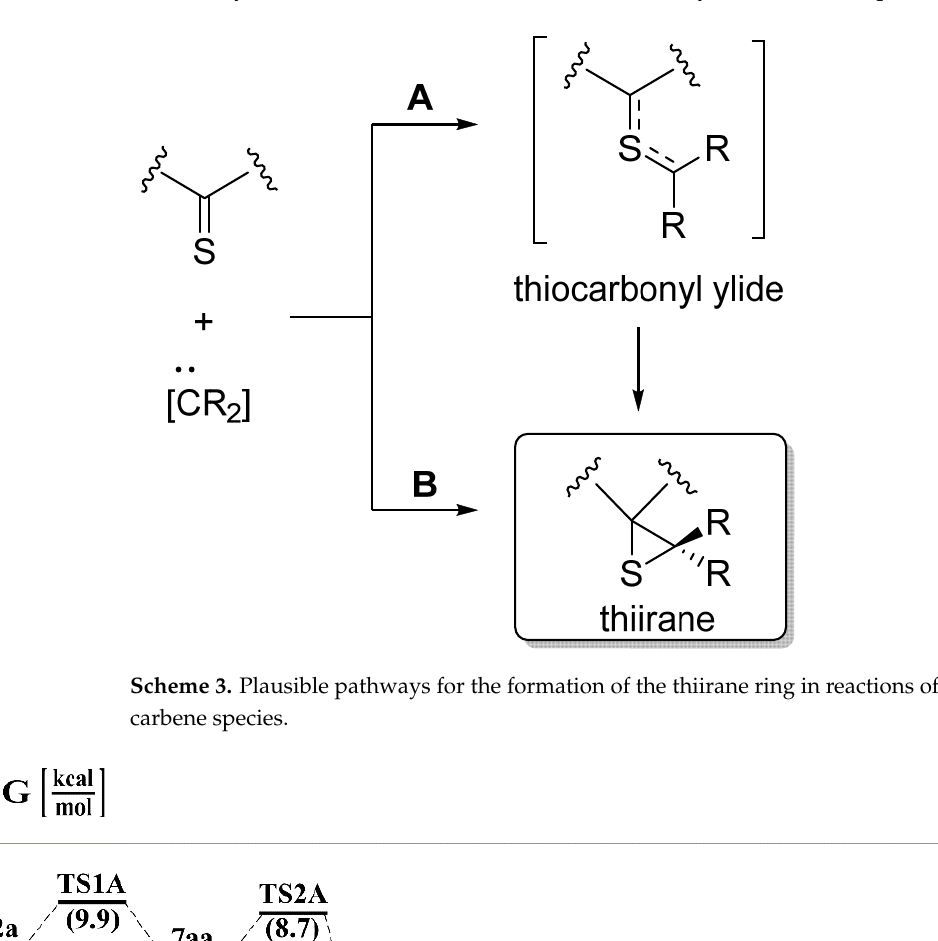
Figure 3. Gibbs free energy profile for the reaction of dichlorocarbene ( 1a ) with 2,2,4,4-tetra-methyl- cyclobutane-1,3-dithione ( 2a ) in the light of wb97xd/6-311g(d,p)(PCM) computational study.